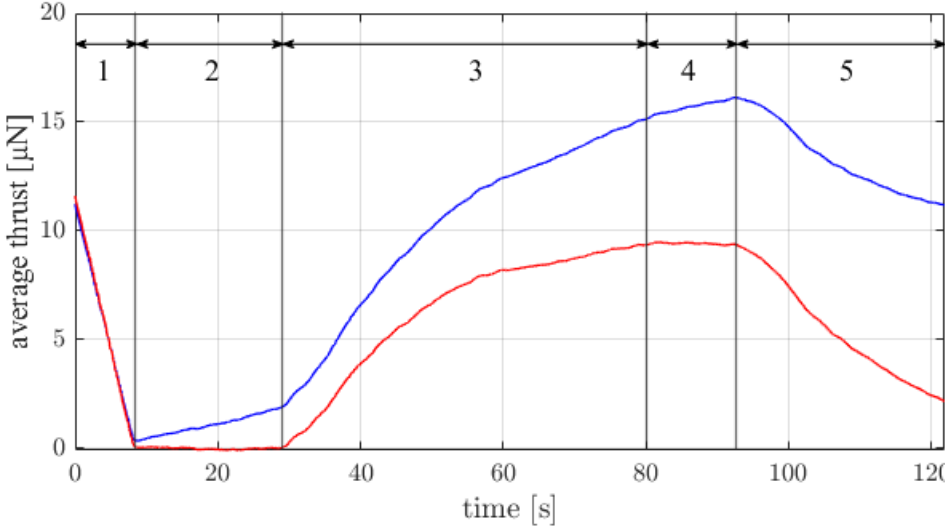
Figure 5. Raw data of a typical thrust evaluation throughout 5 steps of the thrust measurement procedure (blue); corrected evolution of the thrust over the measurement interval without the thermal drift